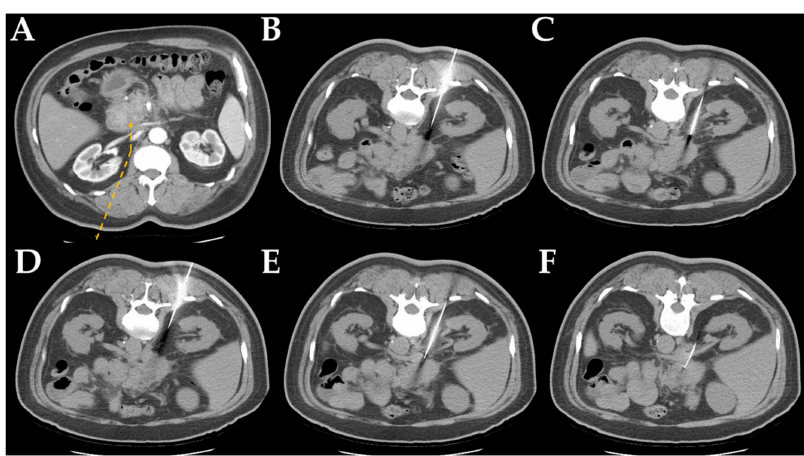
Figure A4. CT-guided core needle biopsy images via detour route 4.